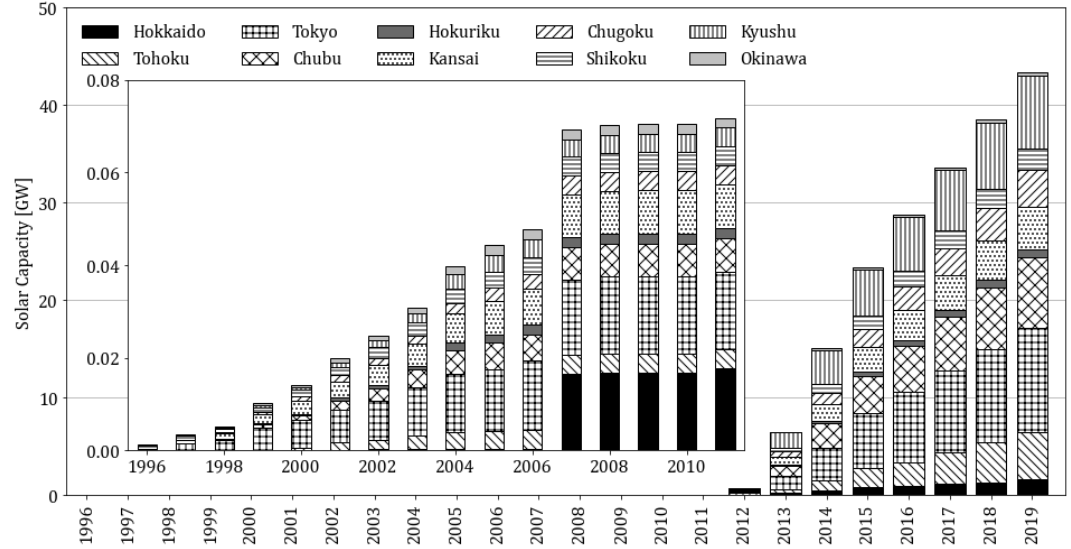
Figure 5. Development of commercial ( ≥ 10 kW) solar PV capacity (GW) in Japan from 1996 to 2019 by electricity power companies’ regional service area.